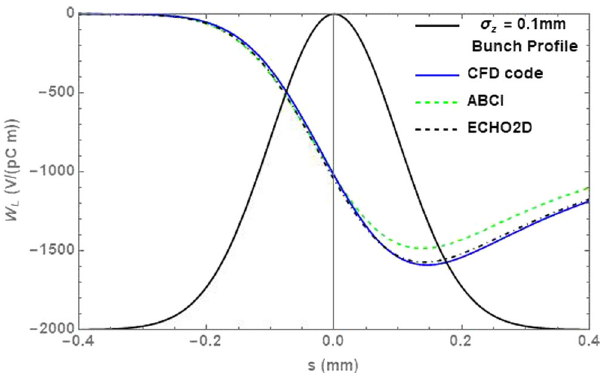
black).FIG. 40. The short-range longitudinal bunch wakes for cells A-G of the XARA design for a electron bunch with σ It can be seen that for decreasing iris radii, the longitudinal wakes become stronger. The dashed black line shows the longitudinal bunch profile in arbitrary units.